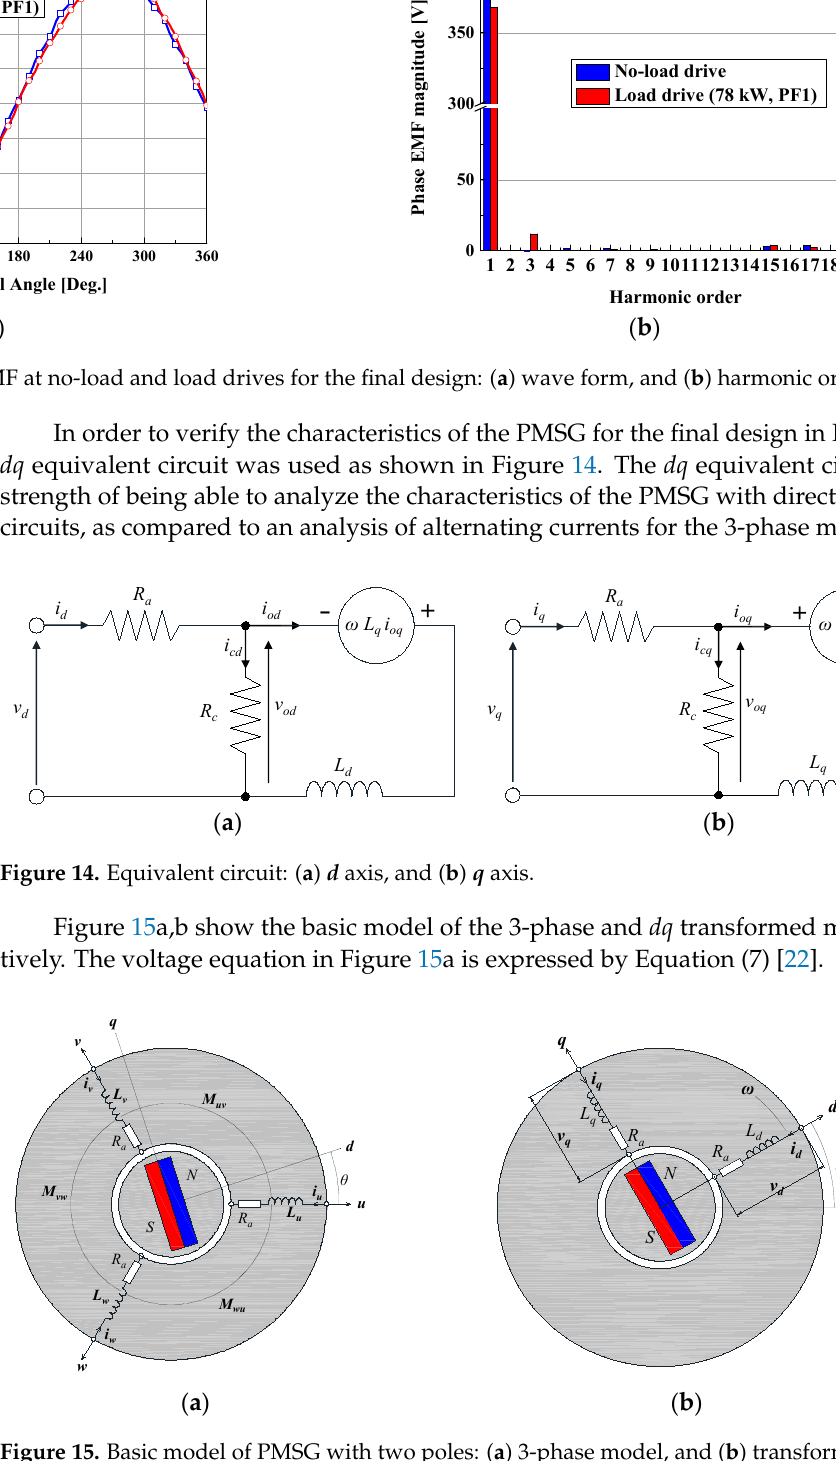
Figure 12. Comparison of the induced EMF at no-load and load drives for the initial and final design: ( a ) wave form, and ( b ) harmonic order.